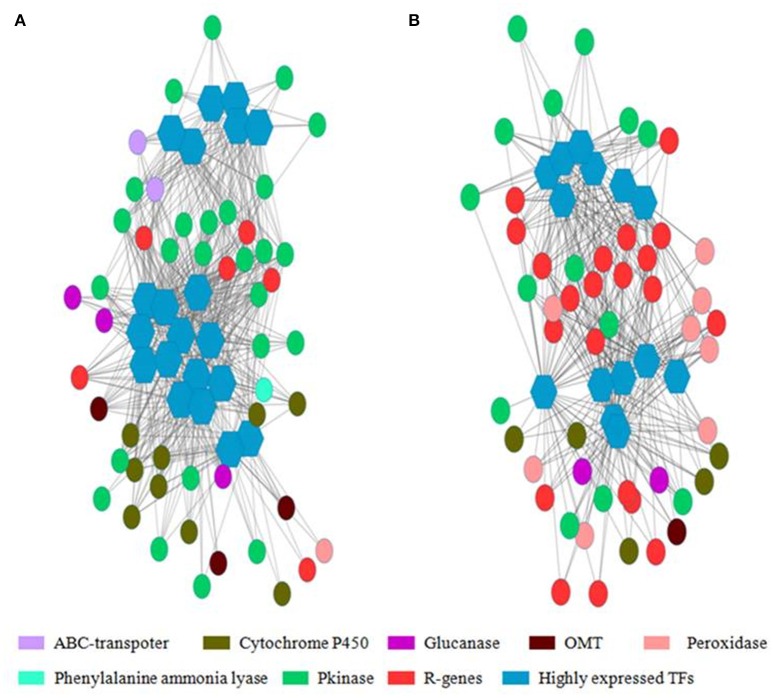
Co-regulated genes expression network of highly expressed transcription factor with other resistance genes. Hexagon represents the transcription factors with more than 20 connections with nearby genes and circle represents the resistance gene, peroxidases, glucanases, cytochrome P450, ABC transporters, Phenylalanine ammonia lyase, protein kinases and O-methyltransferase. Edges represents the degree of connectivity in depicted by weighted gene matrix. (A) Gene network from cluster 1 of WL711. (B) Gene network from cluster 1 of WL711+Lr57.